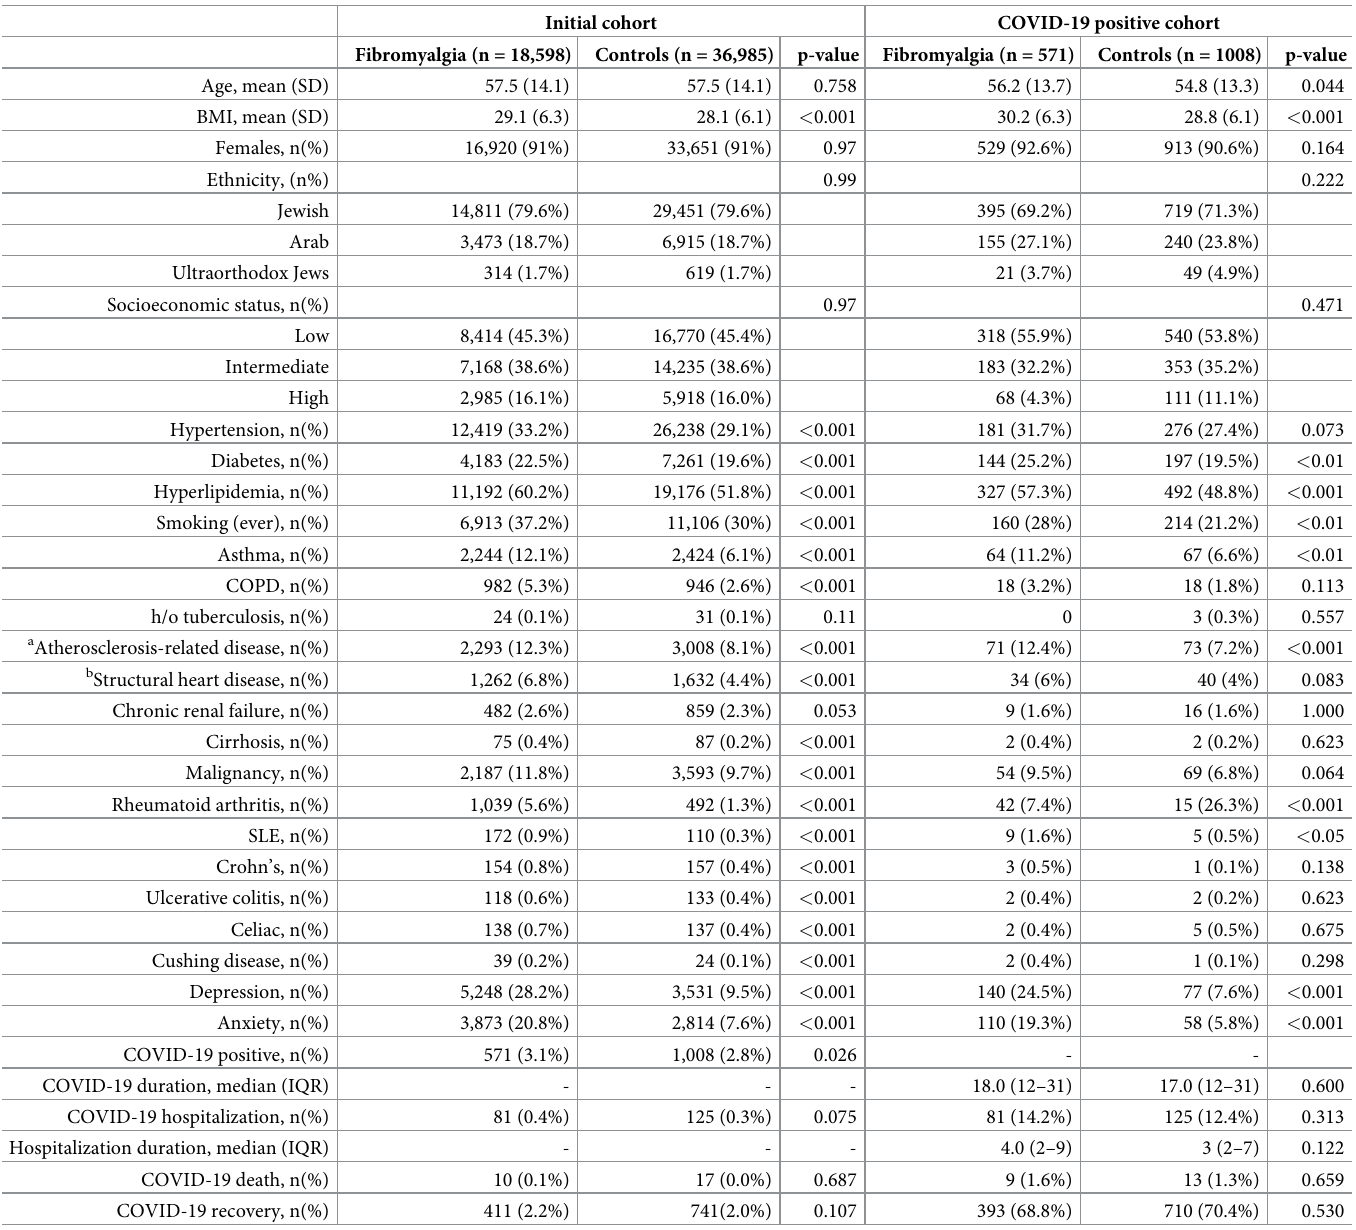
Table 1. Basic characteristics of study